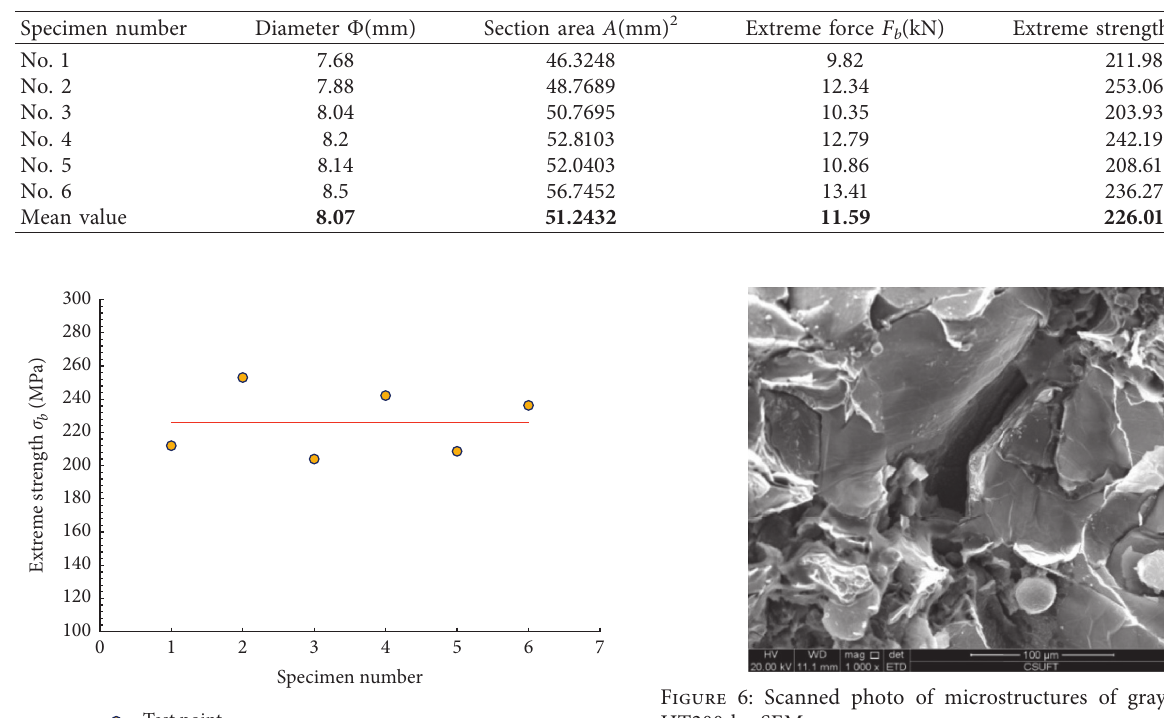
Table 1: Test values of extreme strength of gray cast iron HT200 specimens.